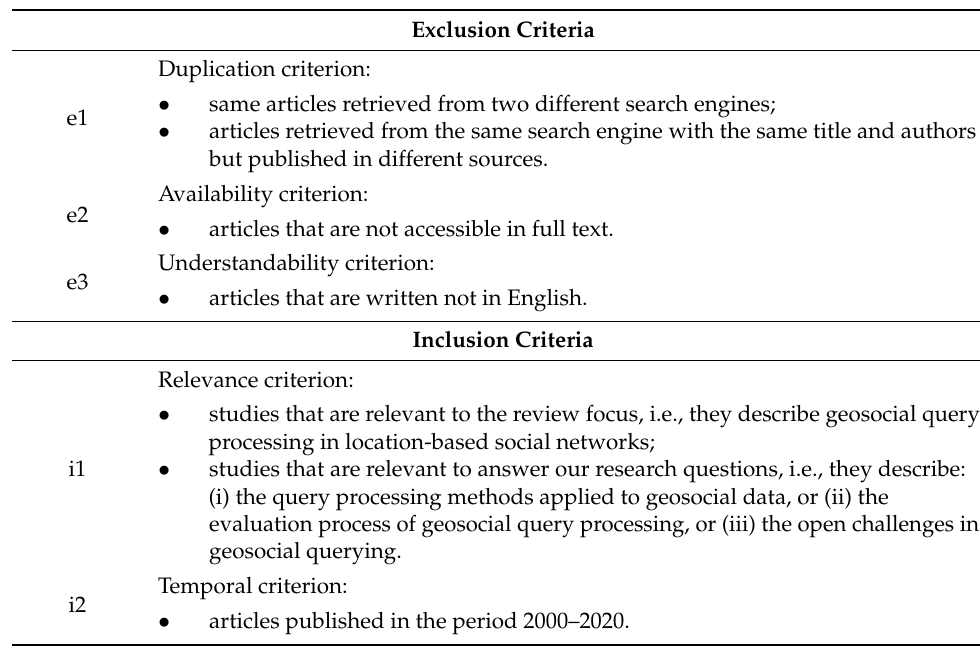
Table 3. Exclusion and inclusion criteria formulated for the